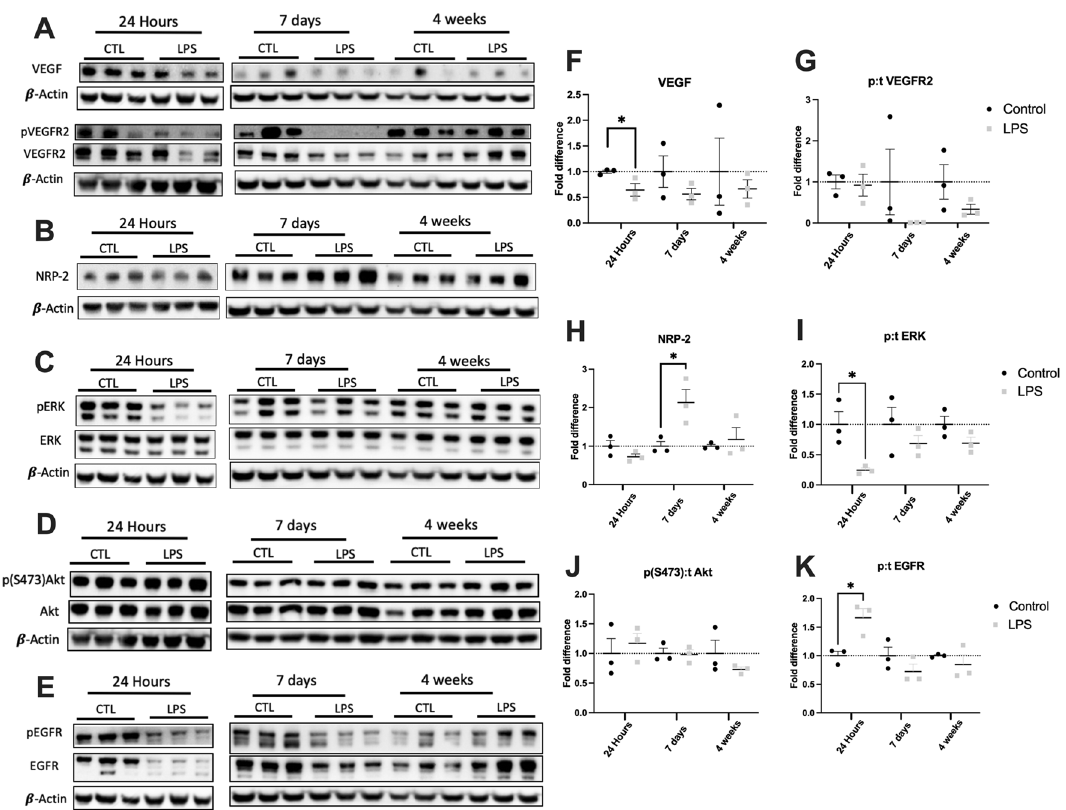
Figure 6. Lung tissue immunoblots. Pulmonary VEGF expression was lower in lipopolysaccharide (LPS)- treated mice compared to controls (CTL) at all time points ( A, F ) but was statistically significant only at 24 h after instillation ( F ). Activation of VEGFR2 (phosphorylated/total receptor VEGFR2) was also lower in LPS- treated mice at 7 days and 4 weeks following instillation ( G ). LPS exposure significantly upregulated expression of the co-receptor neuropilin 2 (NRP-2) at 7 days ( B, H ). Activation of the downstream proliferation marker ERK (phosphorylated/total receptor ERK) was significantly lower at 24 h after LPS ( C, I ) while there were no differences in AKT-S473 activation at the various time points ( D, J ). Activation of an alternative pathway involving the epithelial growth factor receptor (phosphorylated/total EGFR) was significantly increased at 24 h following LPS instillation ( E, K ). Uncropped blots are provided in Supplemental Information Files 1–4. The β-actin for each membrane is displayed below the corresponding antibodies and was used to normalize the expression patterns. Each lane represents a sample from a different mouse. Statistical analysis of protein expression at each time point was performed with Student’s t-test. Results are expressed as mean ± SE. * P <